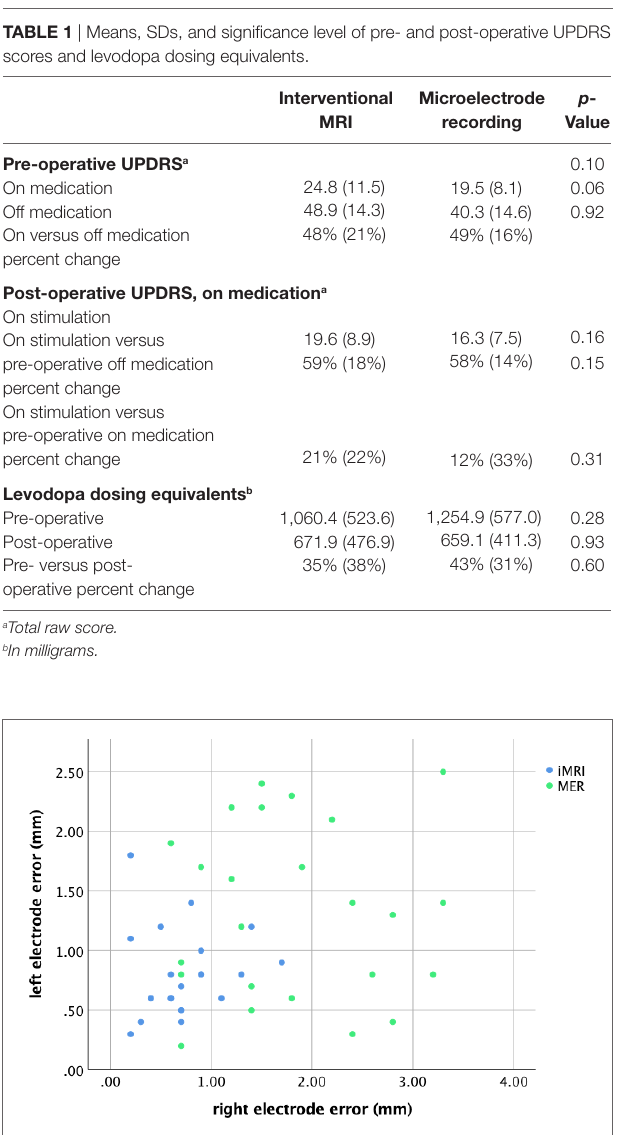
FigUre 2 | Scatterplot demonstrating subthalamic nucleus lead placement error for each subject.